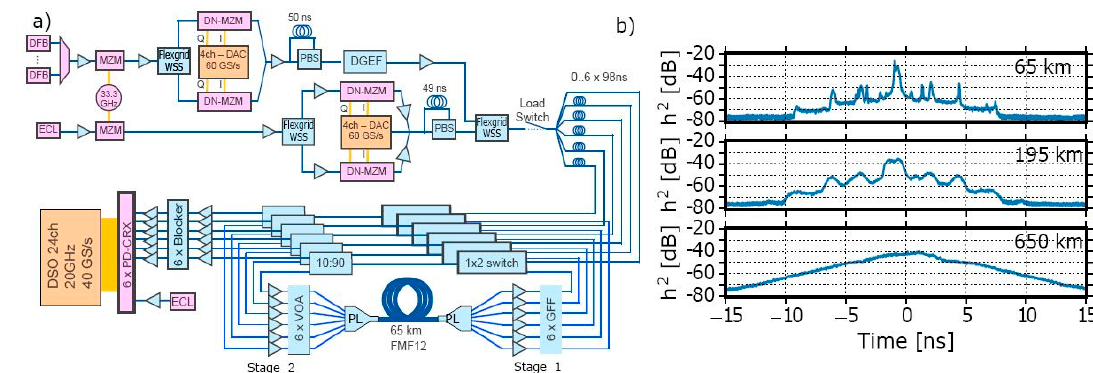
Figure 34. ( a ) Set-up of a 12 × 12 MIMO-based transmission; ( b ) impulse response after 65-, 195-, and 650-km transmission [48].